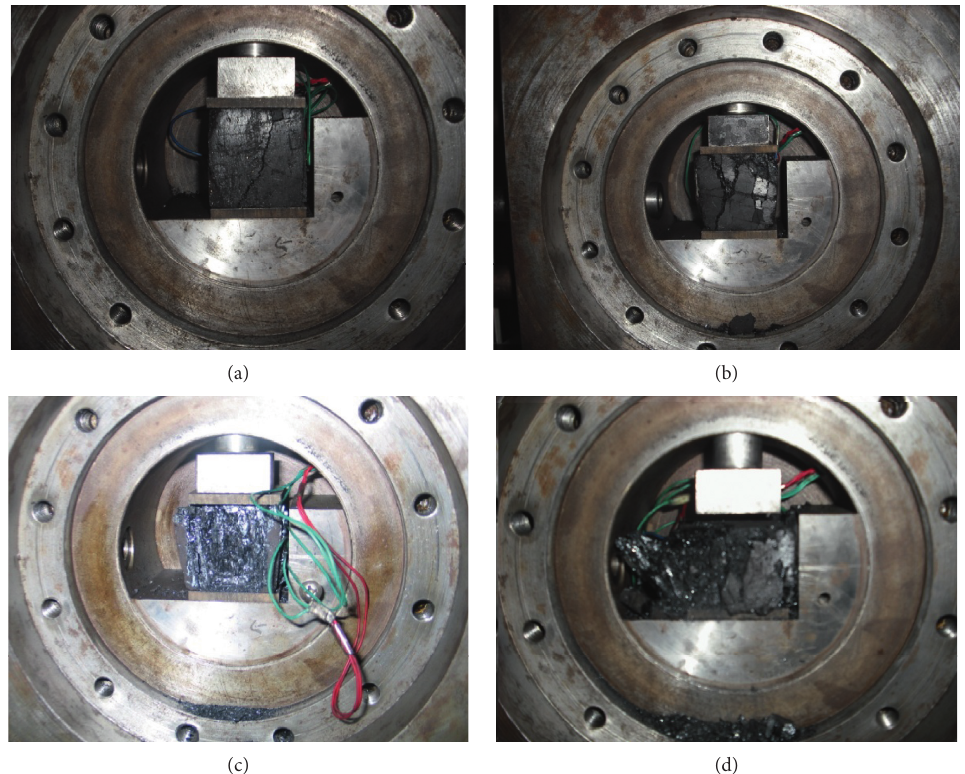
Figure 23: Fracture patterns of coal samples compressed under different gas pressures: (a) without gas effect; (b) under the influence of 1MPa gas pressure; (c) under the influence of 2MPa gas